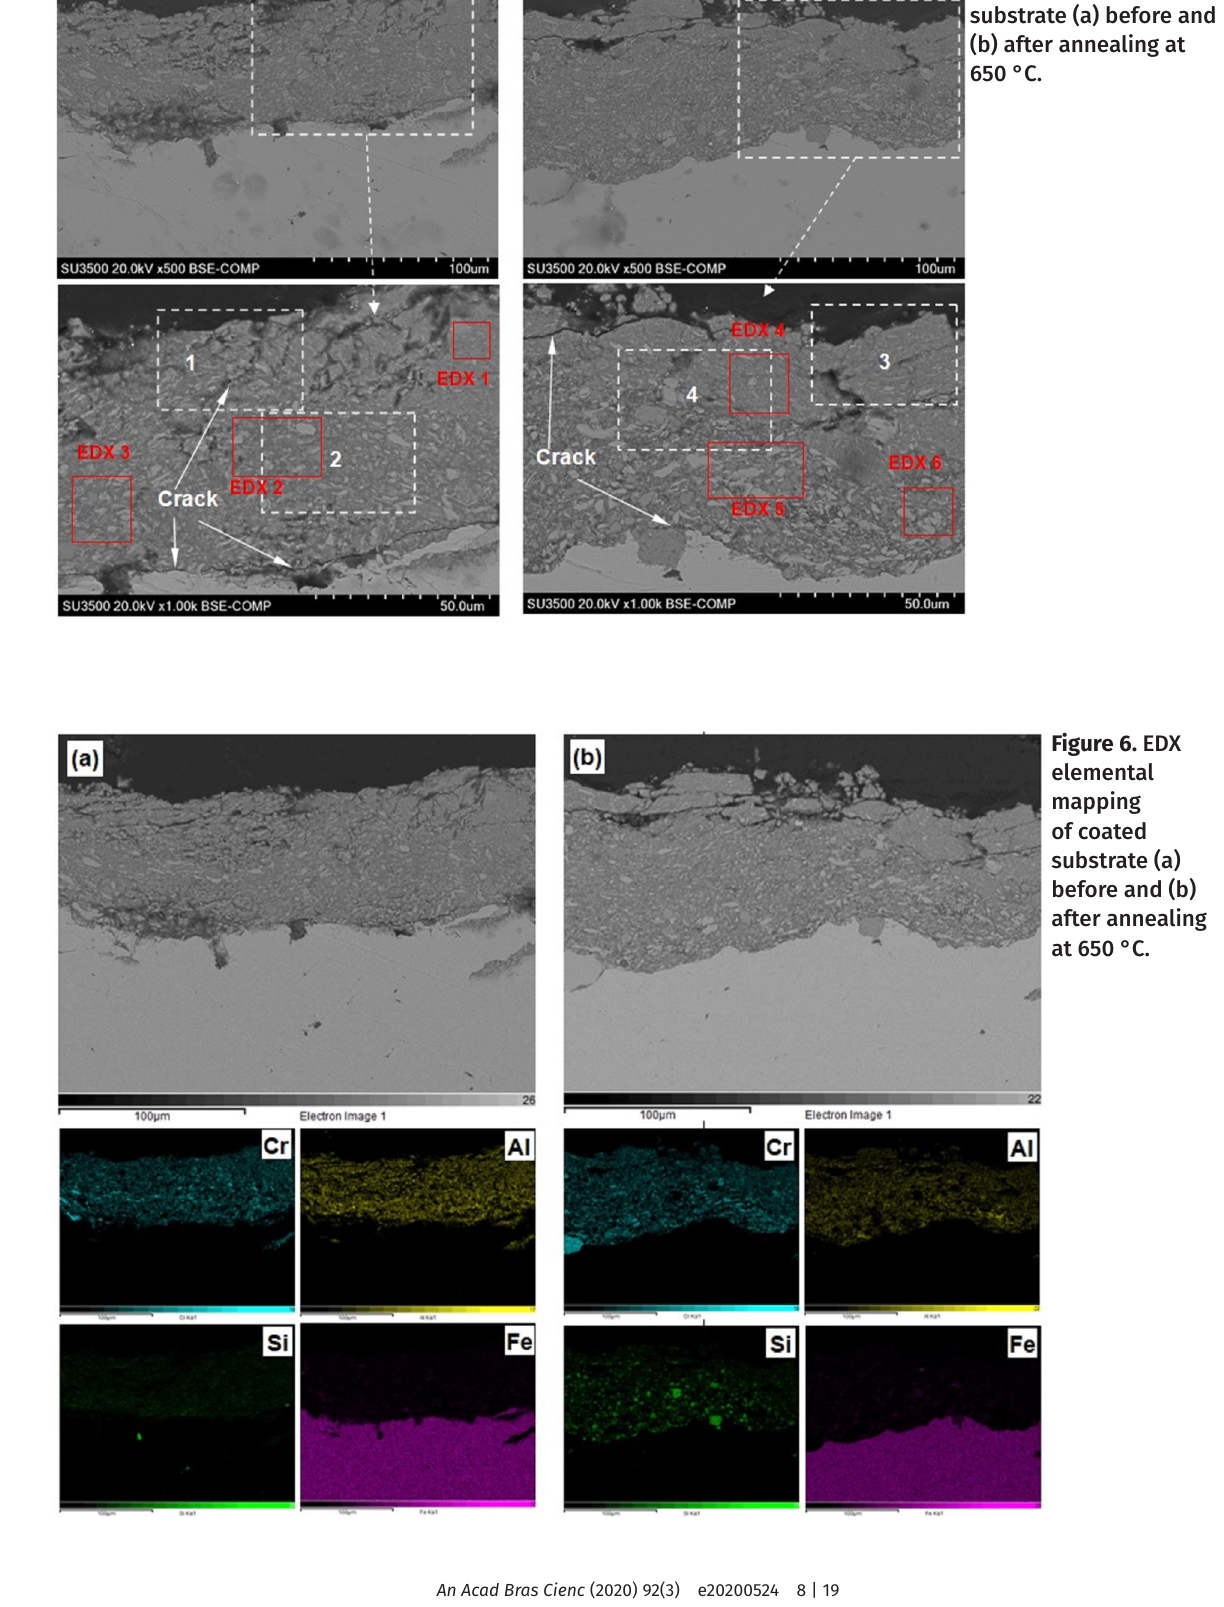
Figure 5. Cross-section SEM images of coated substrate (a) before and (b) after annealing at 650 °C.